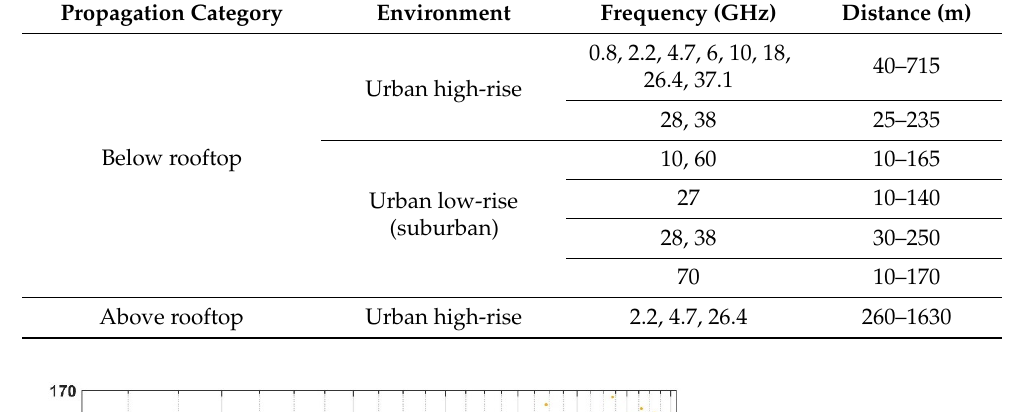
Table 1. Data Sets for NLOS scenarios.